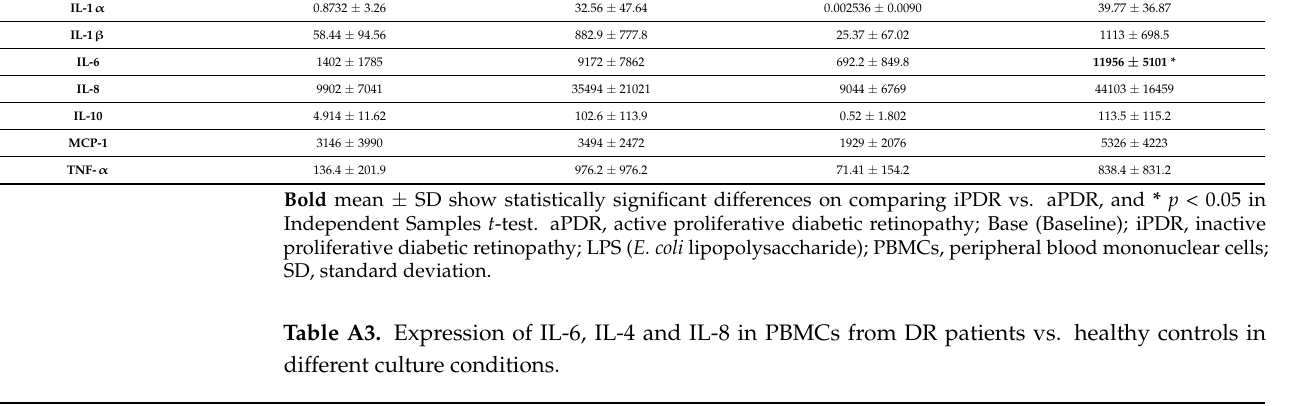
Table A3. Expression of IL-6, IL-4 and IL-8 in PBMCs from DR patients vs. healthy controls in different culture conditions.